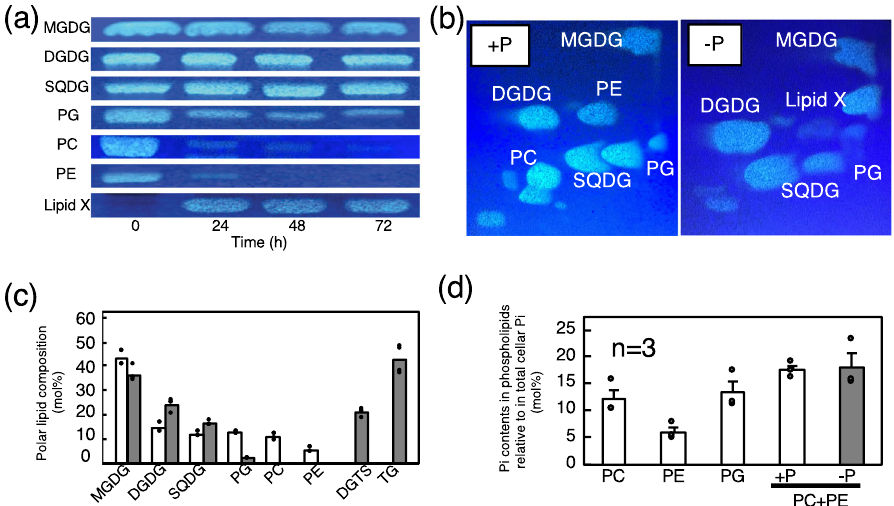
Fig. 3 Lipid remodeling in C. kessleri cells in response to − P stress. a Qualitative TLC analysis of individual polar lipids prepared from cells grown under + P conditions (0 h), and from ones shifted to − P conditions for further growth for 24, 48, and 72 h. Respective lipids came from different regions of the plate (see Supplementary Fig. 2). b Two-dimensional TLC pro fi le of polar lipids in the cells grown for 48 h under + P or − P conditions. c Polar lipid composition in the cells grown for 48 h under + P (white bars) or − P conditions (gray bars). The content of TG was shown as that of its constituent fatty acids, relative to total polar lipids. d The contents of Pi included in individual phospholipids, relative to that in total cellular fraction. The value as to PC + PE under − P conditions indicates the content of Pi derived from the degradation of PC and PE of + P cells, relative to that in total fraction of − P cells. The values shown are averages for two technical replicates for each of two biological replicates ( c ), or averages ± SEM estimated on the basis of the data in Fig. 2d ( n = 3) and c. Some dots are overlapped (refer to source data in Supplementary Data